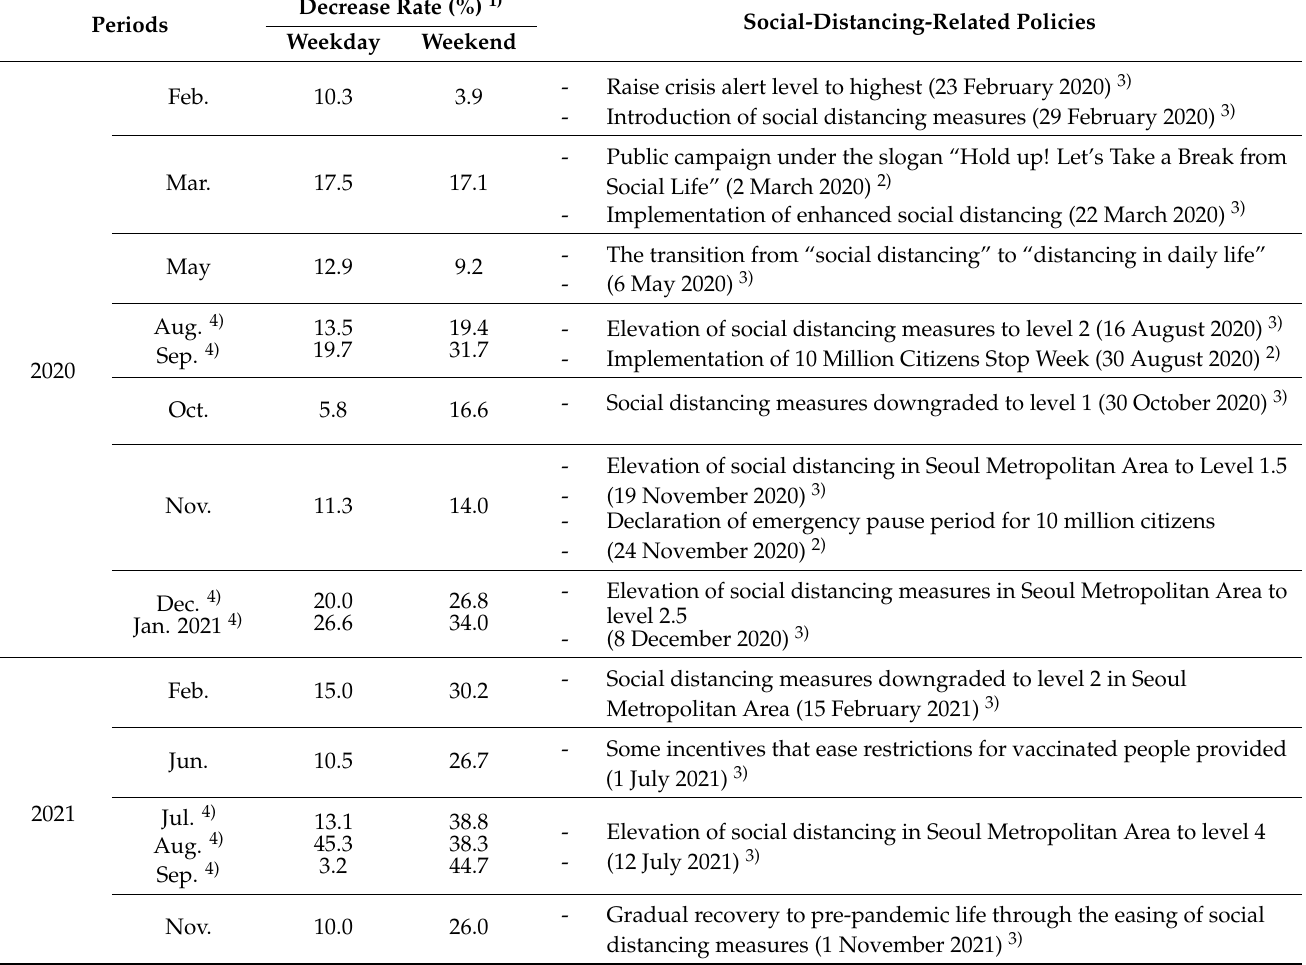
Table 2. Traffic volume decrease per month between February 2020 and November 2021 at Sin- chon